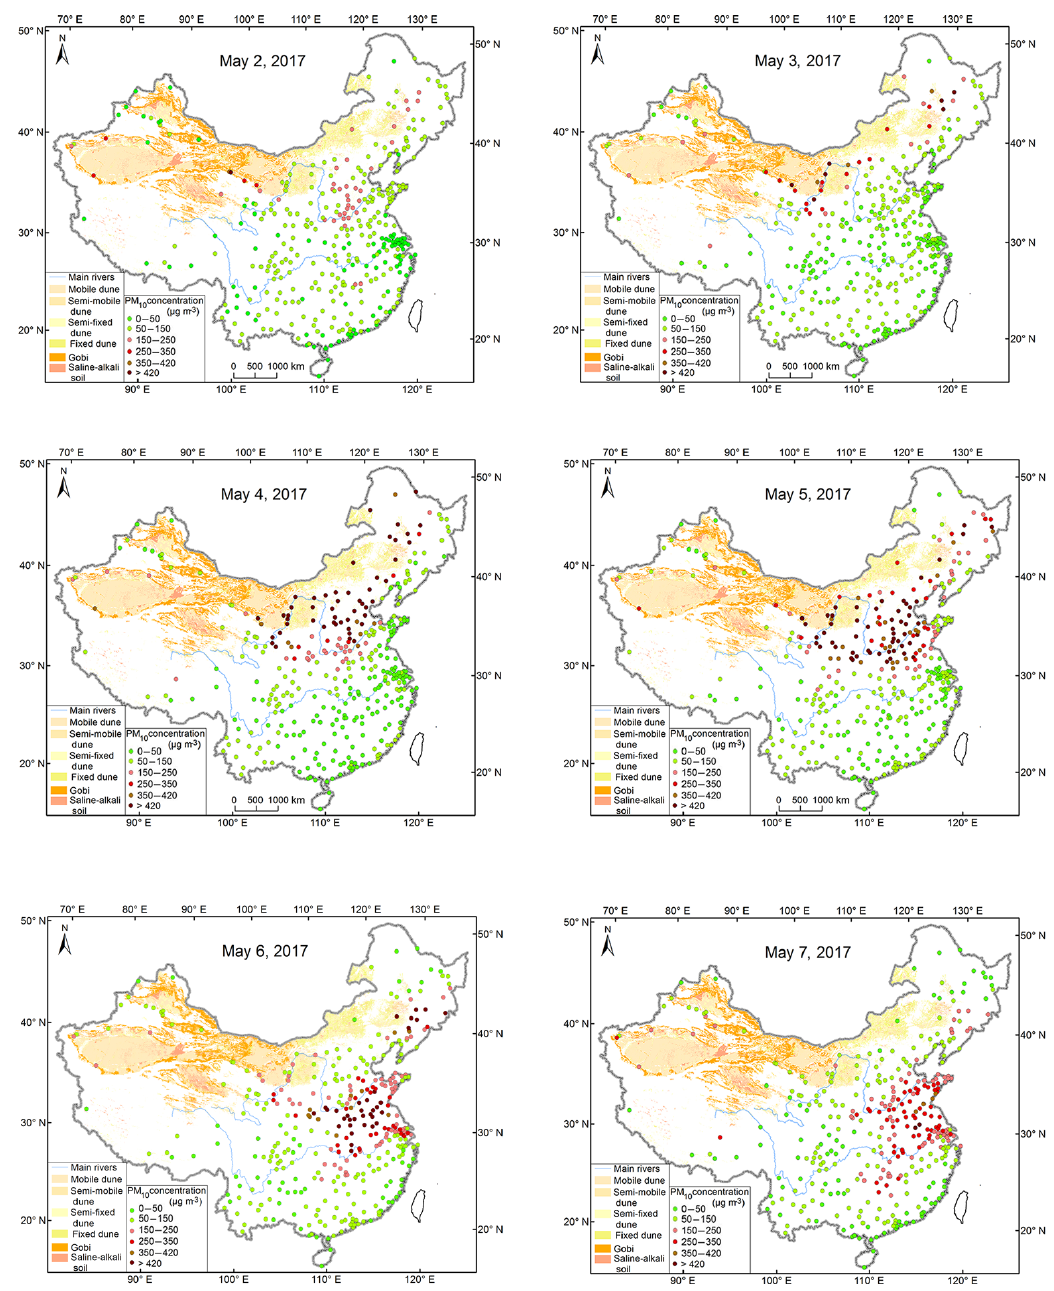
Figure 3. Observations of PM 10 concentrations across the Chinese mainland during 2–7 May 2017. PM 10 concentrations are reported as average hourly based on 24 observations during the day. Land use types are identified across the Chinese mainland according to Wang et al.